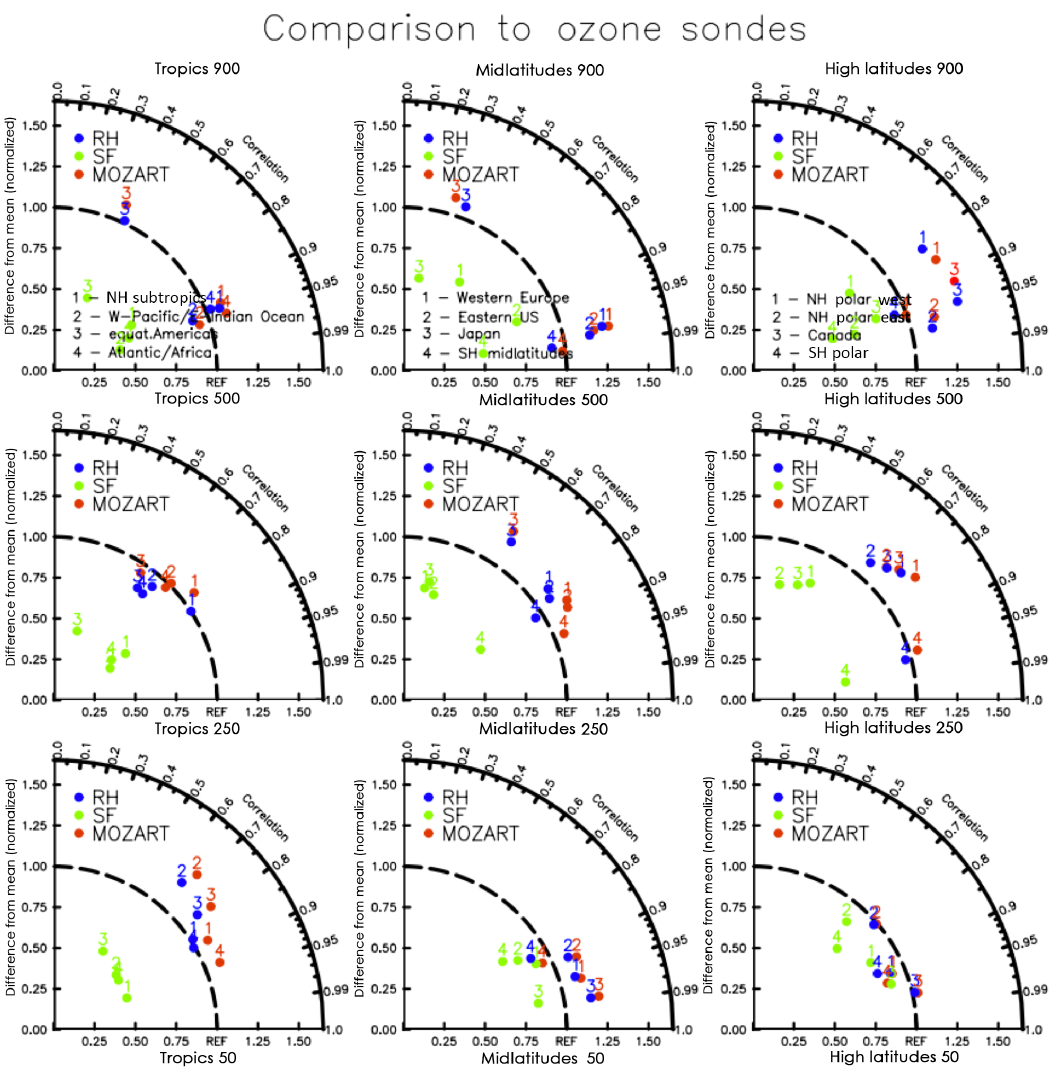
Figure 2. Taylor-like diagrams comparing the mean and correlation of the seasonal cycle between observations (present-day ozonesonde climatology – Tilmes et al., 2012 – from 1995 to 2011 for different regions (tropics, midlatitudes, and high latitudes) and different pressure levels (900, 250, and 50hPa), as in Fig. 12 of Tilmes et al., 2015, and simulations (red: MO; blue: RH; green: